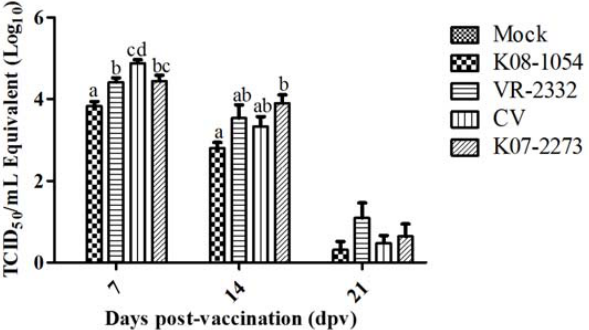
Figure 2. Viral loads in pig serum at 0, 7, 14, and 21 days post ‐ vaccination (dpv). The virus titers were calculated based on the standard curve of the threshold cycle number plotted against the known virus titer of VR ‐ 2332. The bars represent the means, and the error bars represent the standard errors of the mean (SEM). Bars showing different letters represent values significantly different from each other ( p < 0.05). TCID 50 : 50% tissue culture infectious dose. CV: chimeric virus.